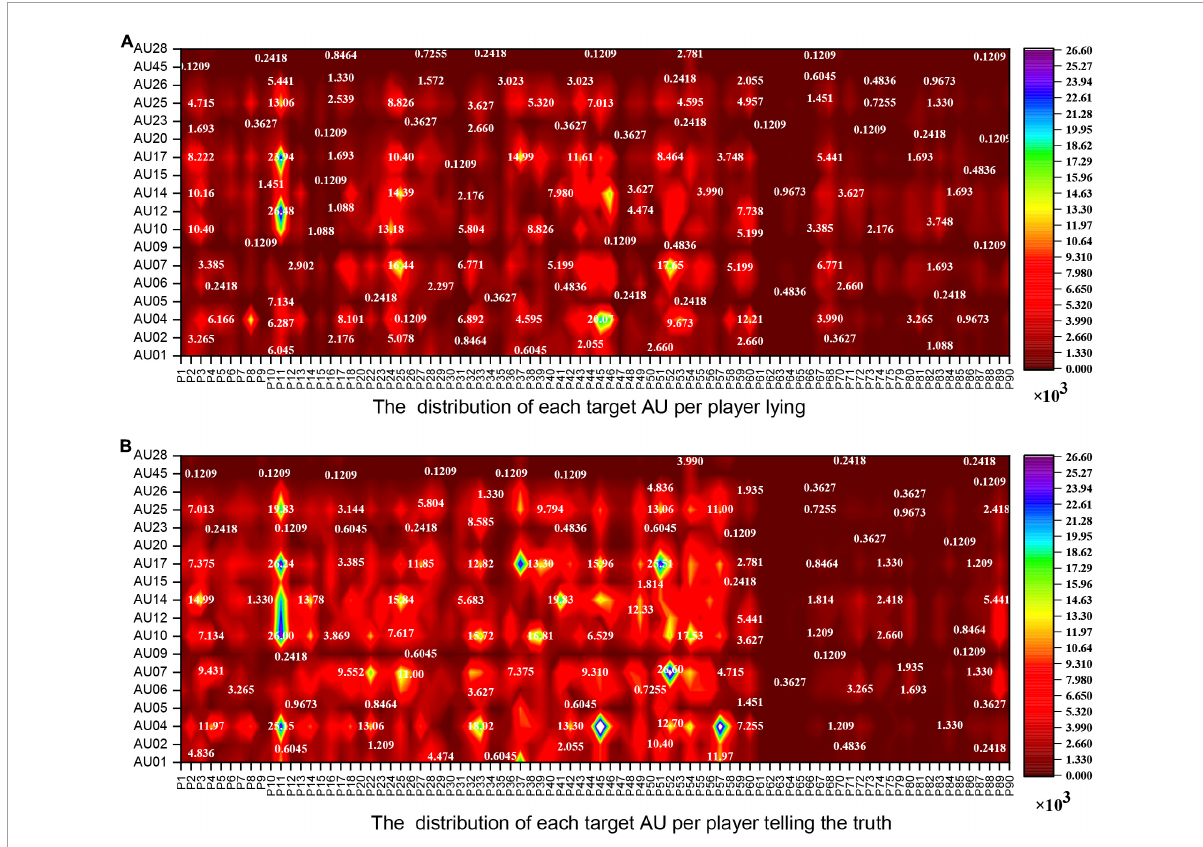
FIGURE3 The contour line plot shows the distribution of action units (AUs) per player. (A) The distribution of lying AUs per player. (B) The distribution of truth-telling AUs per player. P1–P90: The ranking of the players. P1–P60 are healthy undergraduates, P61–P90 are drug addicts. P19, P21, P69, and P76–P78 are precluded in this